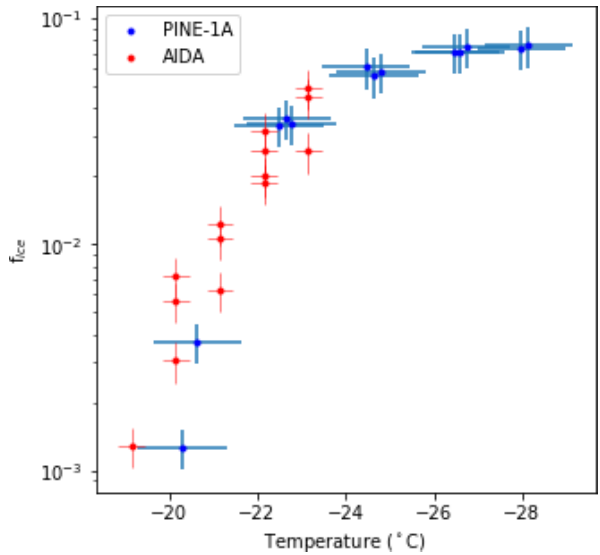
Figure 9. Ice-active particle fraction f ice measured with PINE-1A for ATD as a function of temperature (see also Fig. 8), in compari- son to f ice measured in an AIDA cloud expansion experiment with the same aerosol, right after the PINE-1A runs were